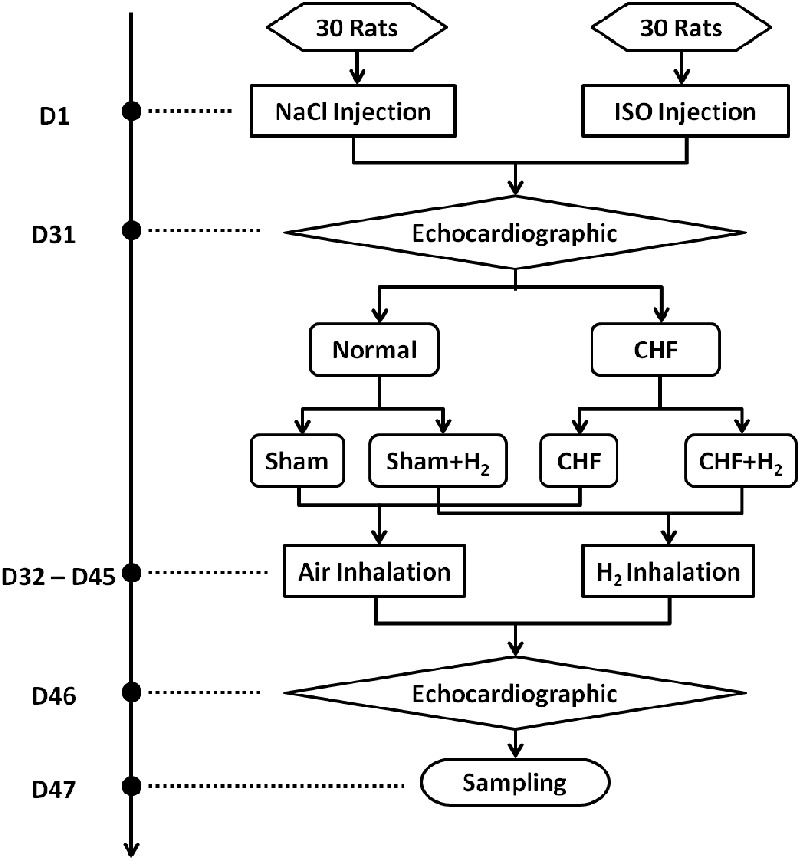
The time course of the study on each animal. The protocols and interventions on each animal and when they were performed were indicated.